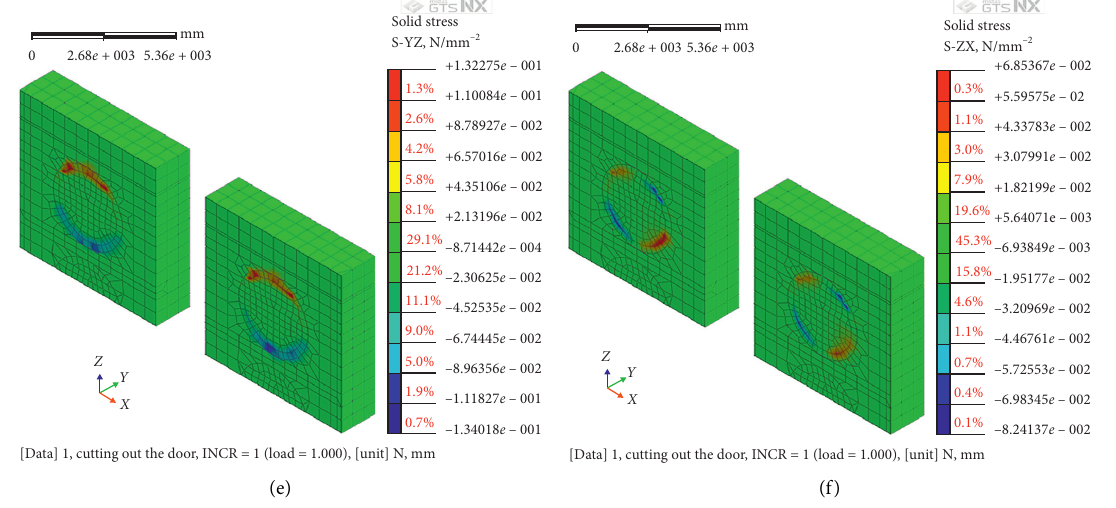
Figure 10: Stresses of reinforcement soil. (a) Stress of σ x . (b) Stress of σ y . (c) Stress of σ z . (d) Stress of τ xy . (e) Stress of τ yz . (f) Stress of τ xz